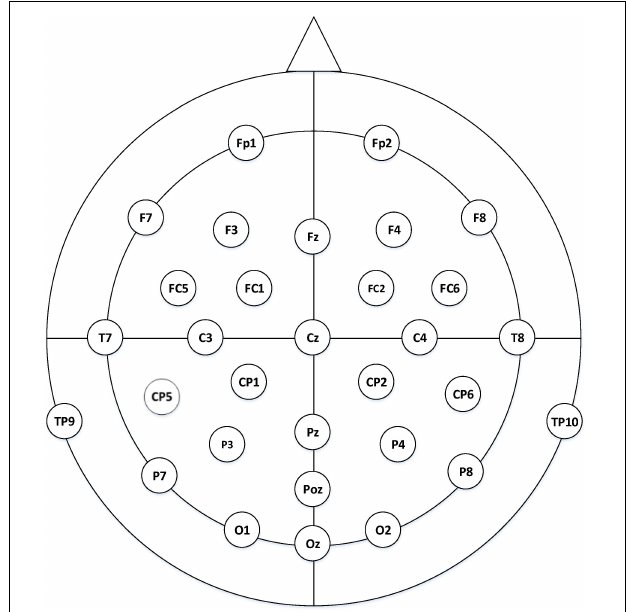
FIGURE 4 | Sensor position in the EEG experiments: thirty-two electrodes were used based on the extended international 10–20 system, of which the ECG electrode was